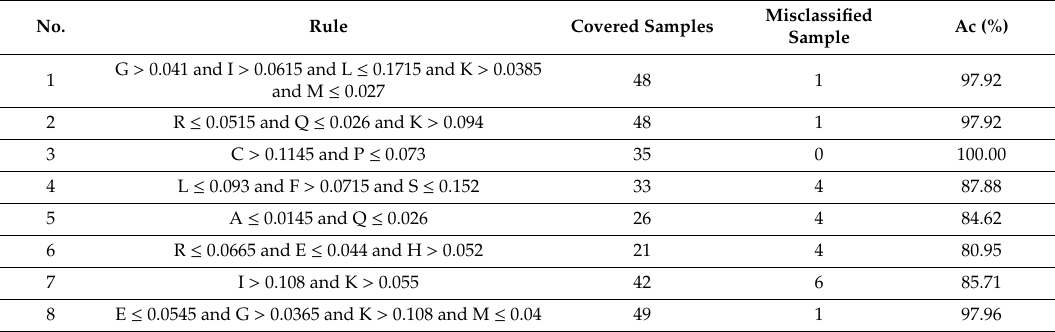
Table 7. Eight if-then rules for the prediction of anticancer peptides using random forest and amino acid